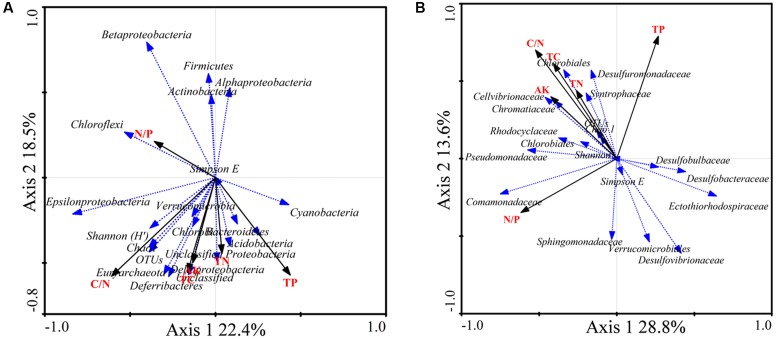
Redundancy analysis (RDA) ordination biplot showing the relationships between environmental variables and total 16S rRNA (A) and nifH
(B) gene groups. Only the most abundant groups are shown in the biplot.